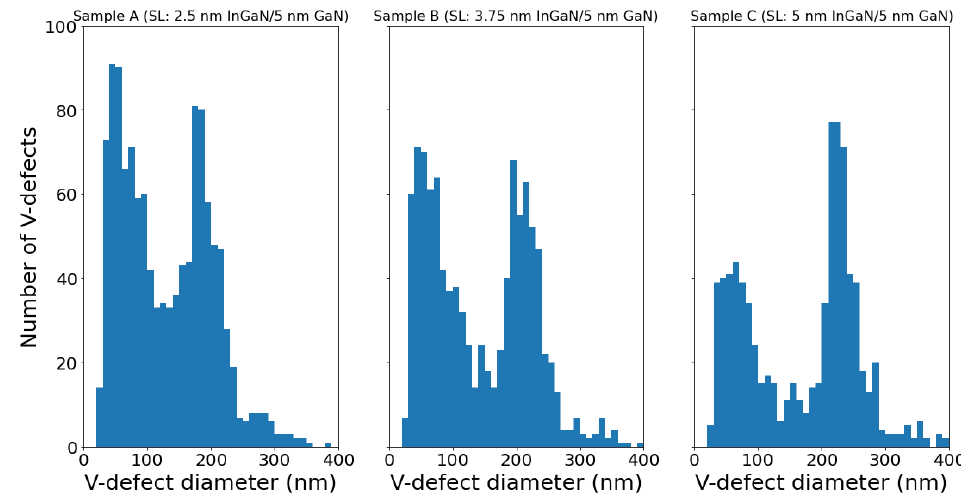
Figure 3. V-defect distribution for samples A, B, and C.